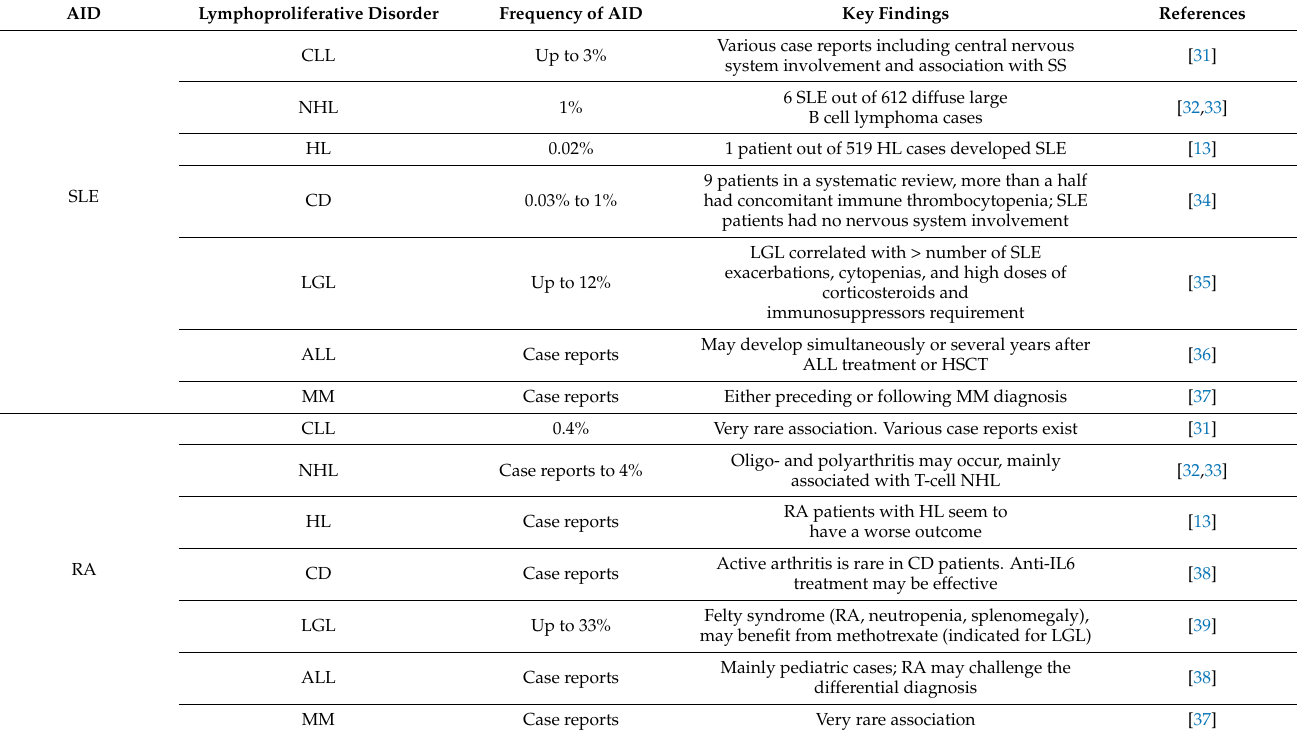
Table 2. Autoimmune diseases (AID) complicating lymphoproliferative disorders. AID Lymphoproliferative Disorder Frequency of AID Key